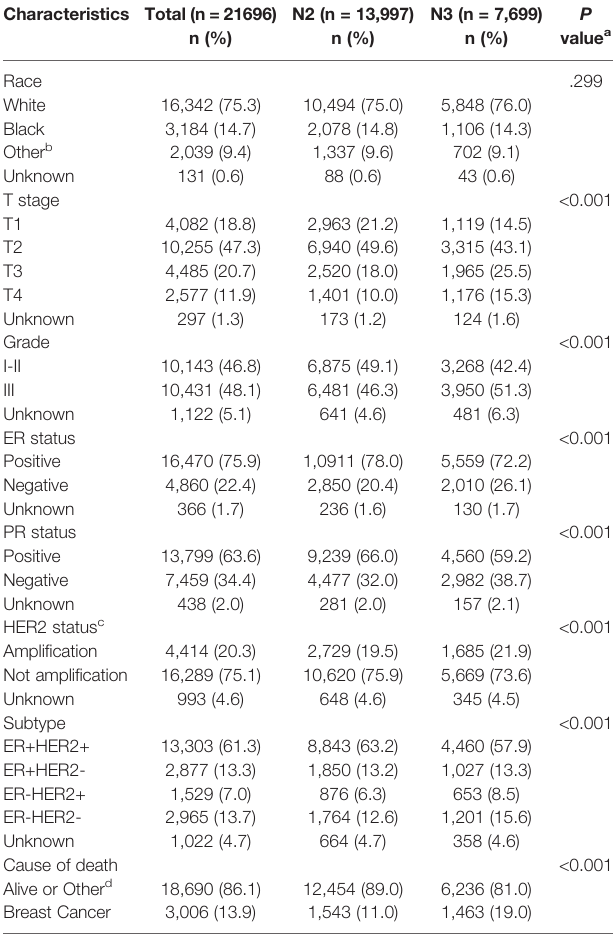
TABLE 1 | Baseline characteristics according to N stage in N2 – 3